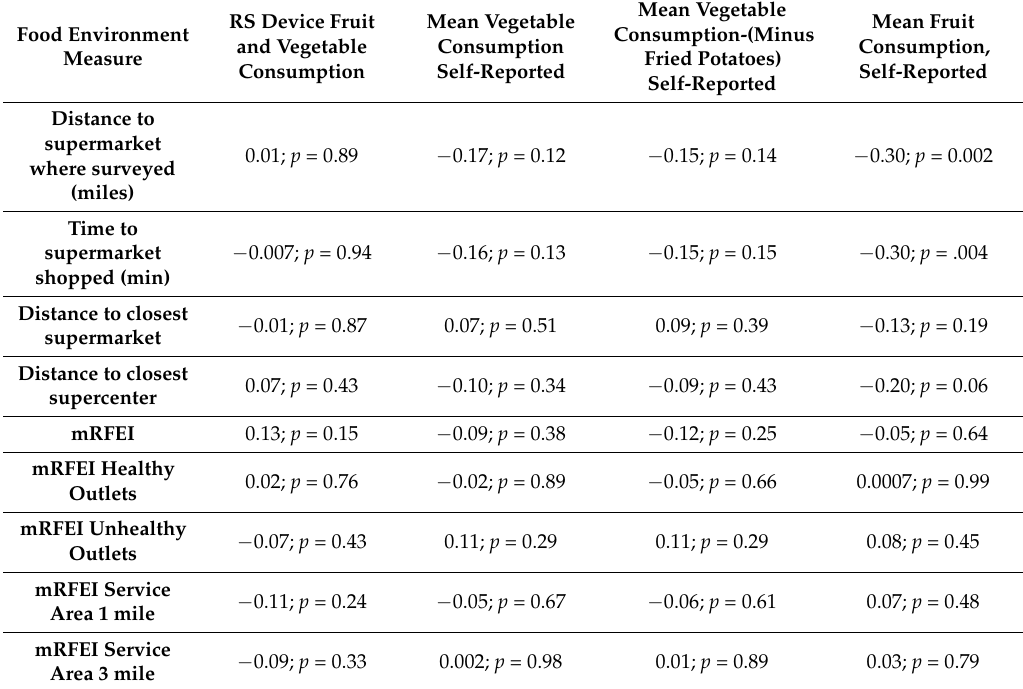
Table 2. Spearman’s rho and p -values for correlations between spatial variables and objectively-assessed and self-reported fruit and vegetable